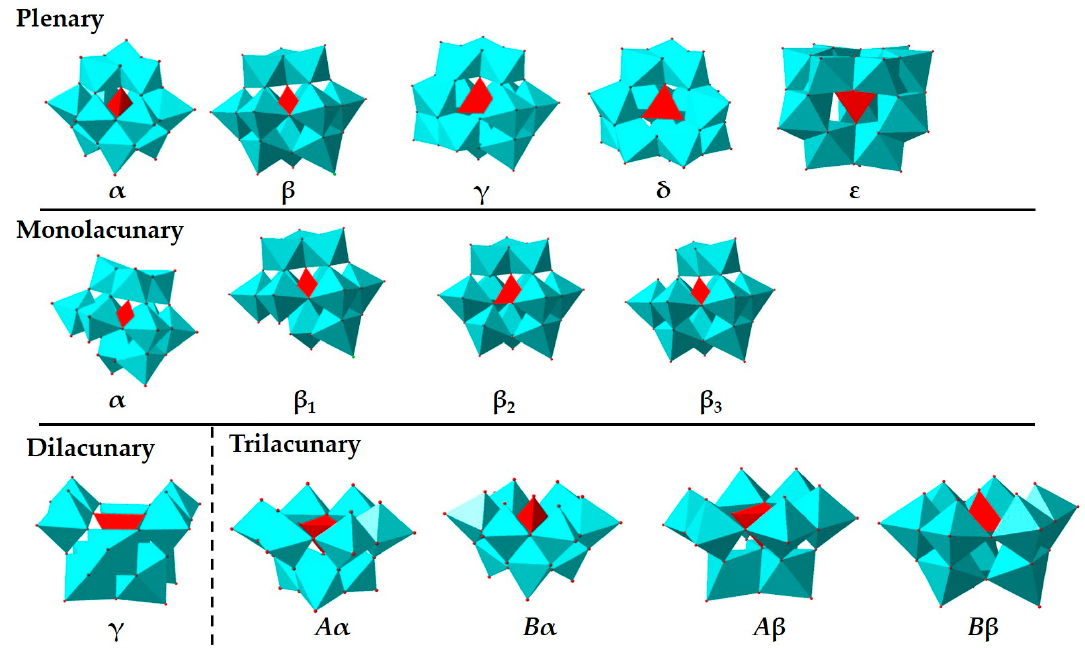
Figure 1. Isomers and mono- to trilacunary derivatives of the Keggin structure; color code: MO 6 octahedron, light blue; XO 4 tetrahedron, red (X = central atom).